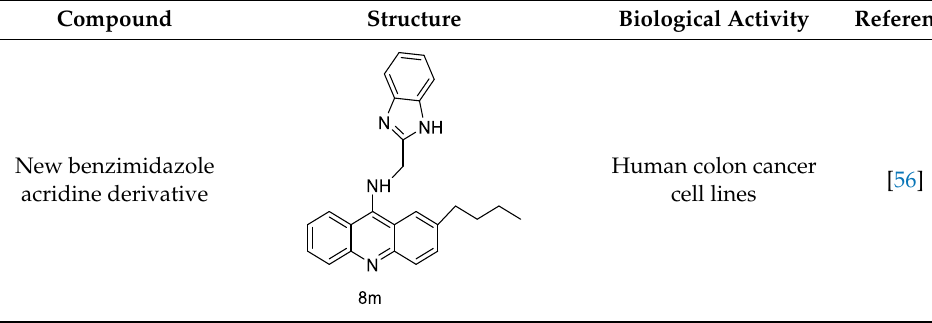
Figure 6. SAR of acridine benzimidazole. Table 7. Benzimidazole as an anti-tumour agent.